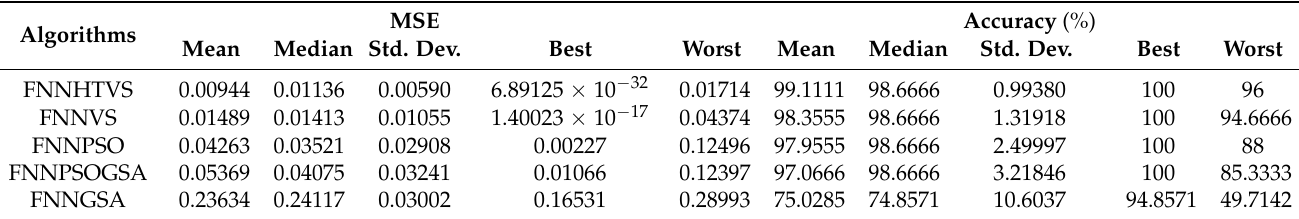
Table 9. Statistical fault classification results for H n = 9.